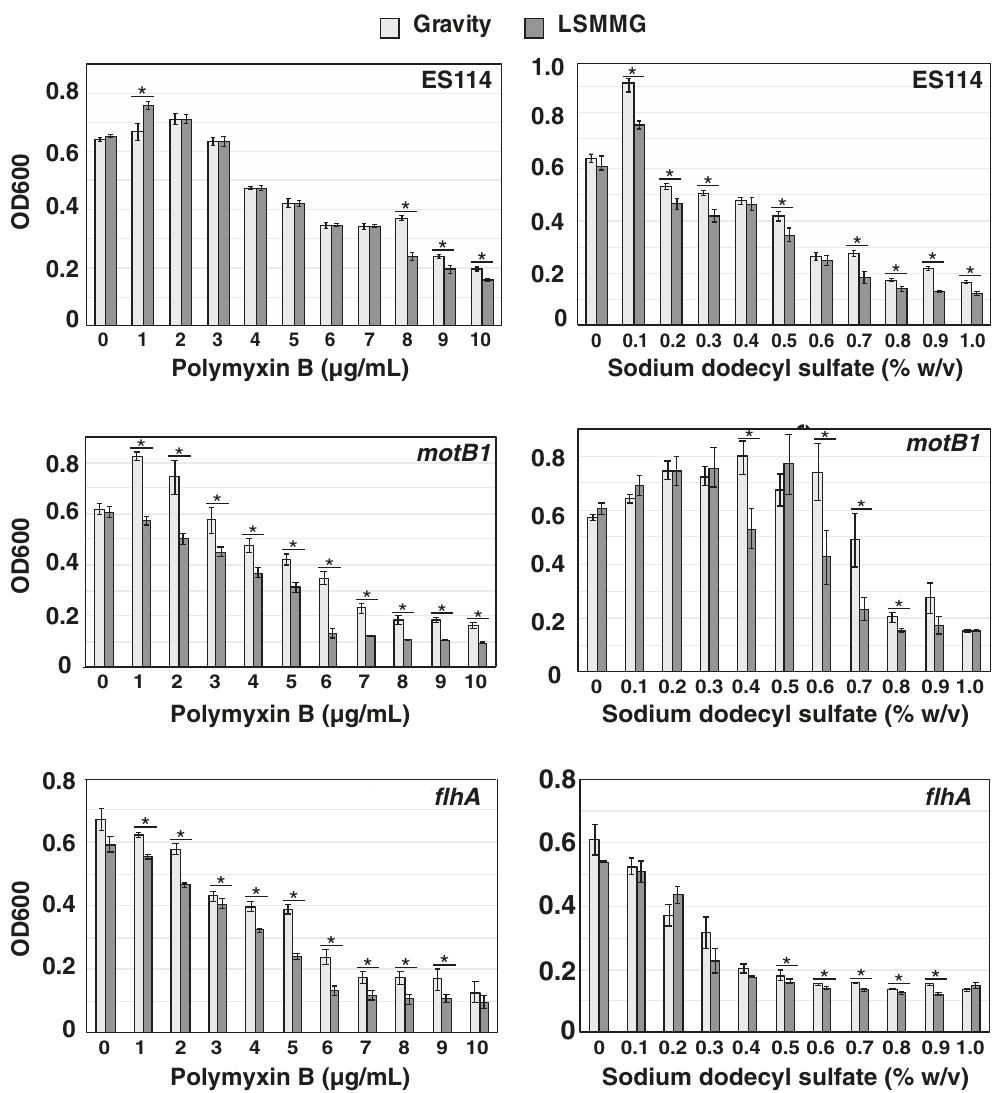
Fig. 5 Dose – response of Vibrio fi scheri cell densities in the presence of polymyxin B and sodium dodecyl sulfate. Cultures of wild-type V. fi scheri ES114 and motility mutants ( motB1 and fl hA ) were grown for 12 h under gravity (light gray) and low-shear modeled microgravity (LSMMG) conditions. Error bars indicate the standard error of the mean. Asterisks indicate signi fi cant differences between the data sets ( p < 0.05; Mann – Whitney U